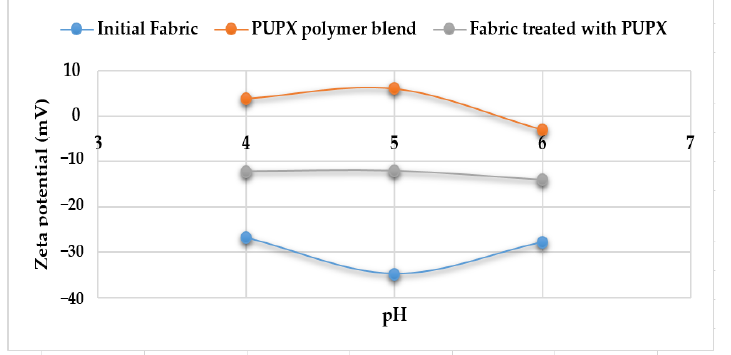
Figure 15. Zeta potential of the non-treated fabric, PUPX polymer blend, and PUPX-treated